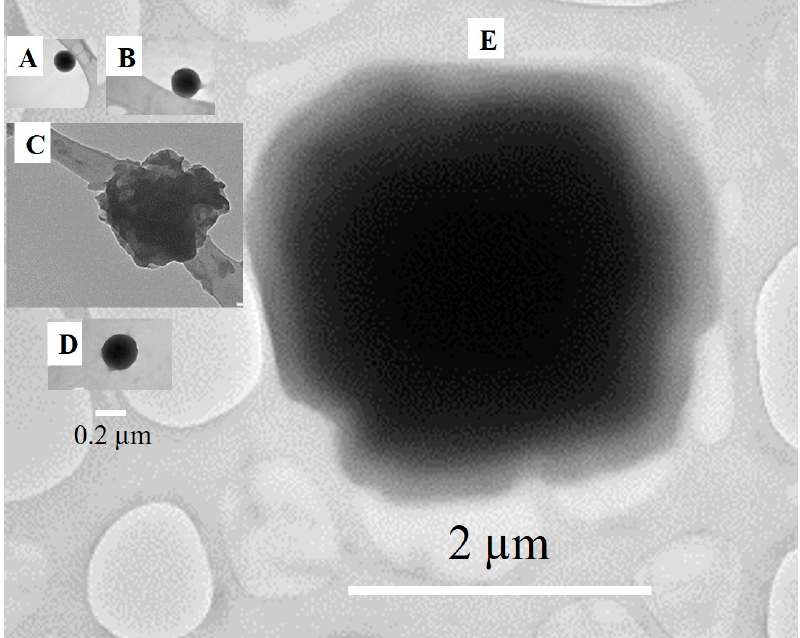
Figure 3. TEM image of individual colloidal particles (dark shape, the grey features are the TEM grid) produced by antisolvent precipitation into water of 2 ( A ), 5 ( B ) and 10 mg HEE/mL ethanol ( C ) on the magnetic stirrer, of 2 mg LR-HEE/mL ethanol on the magnetic stirrer ( D ) and 2 mg HEE/mL ethanol in nonstirred conditions ( E ). Images are scaled to align scale bars, representing 0.2 ( A – D ) or 2 µm ( E ).